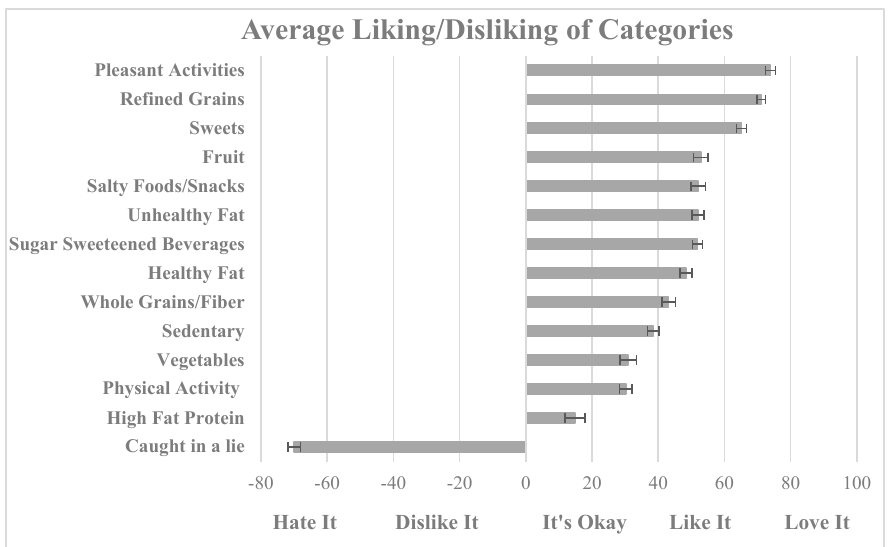
Figure 2. Box Plot of knowledge scores. 3.3. Survey Evaluation (Acceptability and Usefulness) The study sample of college women found the online survey acceptable and useful. Nearly all (92%) reported at least agree that they could answer questions quickly and found survey questions to be relevant to them as a college student. Slightly fewer women (82.6%) at least agreed the survey was helpful in reflecting on current behaviors and 80%